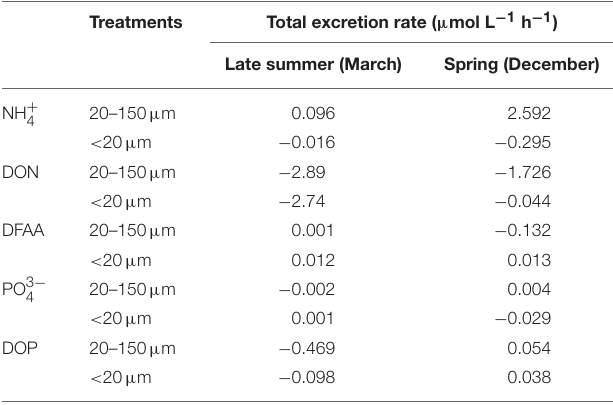
TABLE 2 | Total excretion rates for ammonium (NH + 4 ), dissolved organic nitrogen (DON), dissolved free amino acid (DFAA), phosphate (PO 3 − 4 ), and dissolved organic phosphorus (DOP), in late summer and spring.